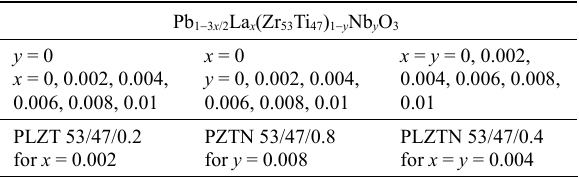
Stoichiometric composition for each PZT system